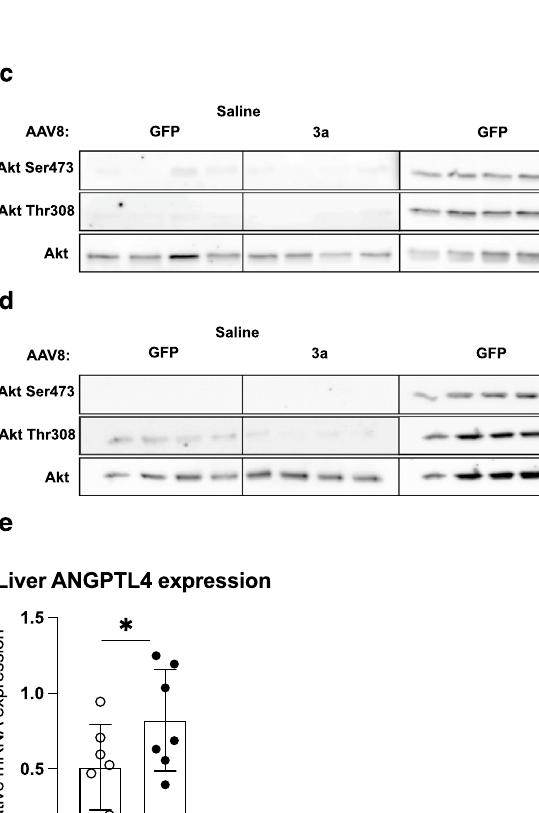
ogy was used to generate ANGPTL4 KO cells (Supplementary Fig. S4 online). The expression of other members of the ANGPTL family (e.g. ANGPTL6 and 8, expressed in the liver) as well as several hepatokines known to be involved in glucose metabolism was not altered in ANGPTL4 KO cells (Fig. S4e). As shown in Fig. 3e, CM of ANGPTL4 -KO HepG2 cells transduced with HCV-3a core did not induce myotube IR. The direct role of